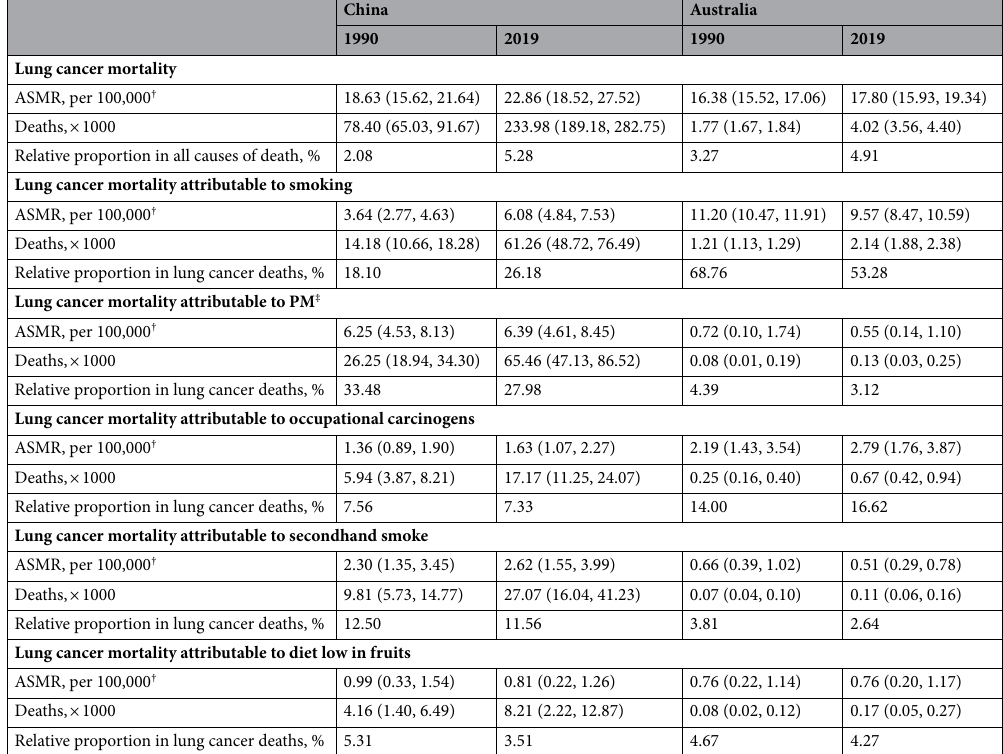
Table 2. Lung cancer mortality among women in China and Australia between 1990 and 2019. †ASMR: age-standardized mortality rate; ‡PM: particulate matter including ambient particulate matter pollution and household air pollution from solid fuels.